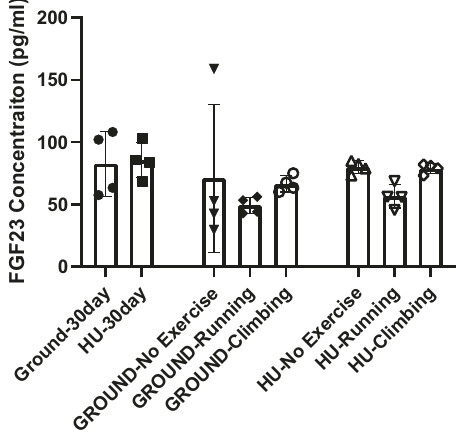
Fig. 3 Plasma FGF23 was unaltered after hind limb unloading. Plasma FGF23 was similar across groups and time points. Bars: Mean